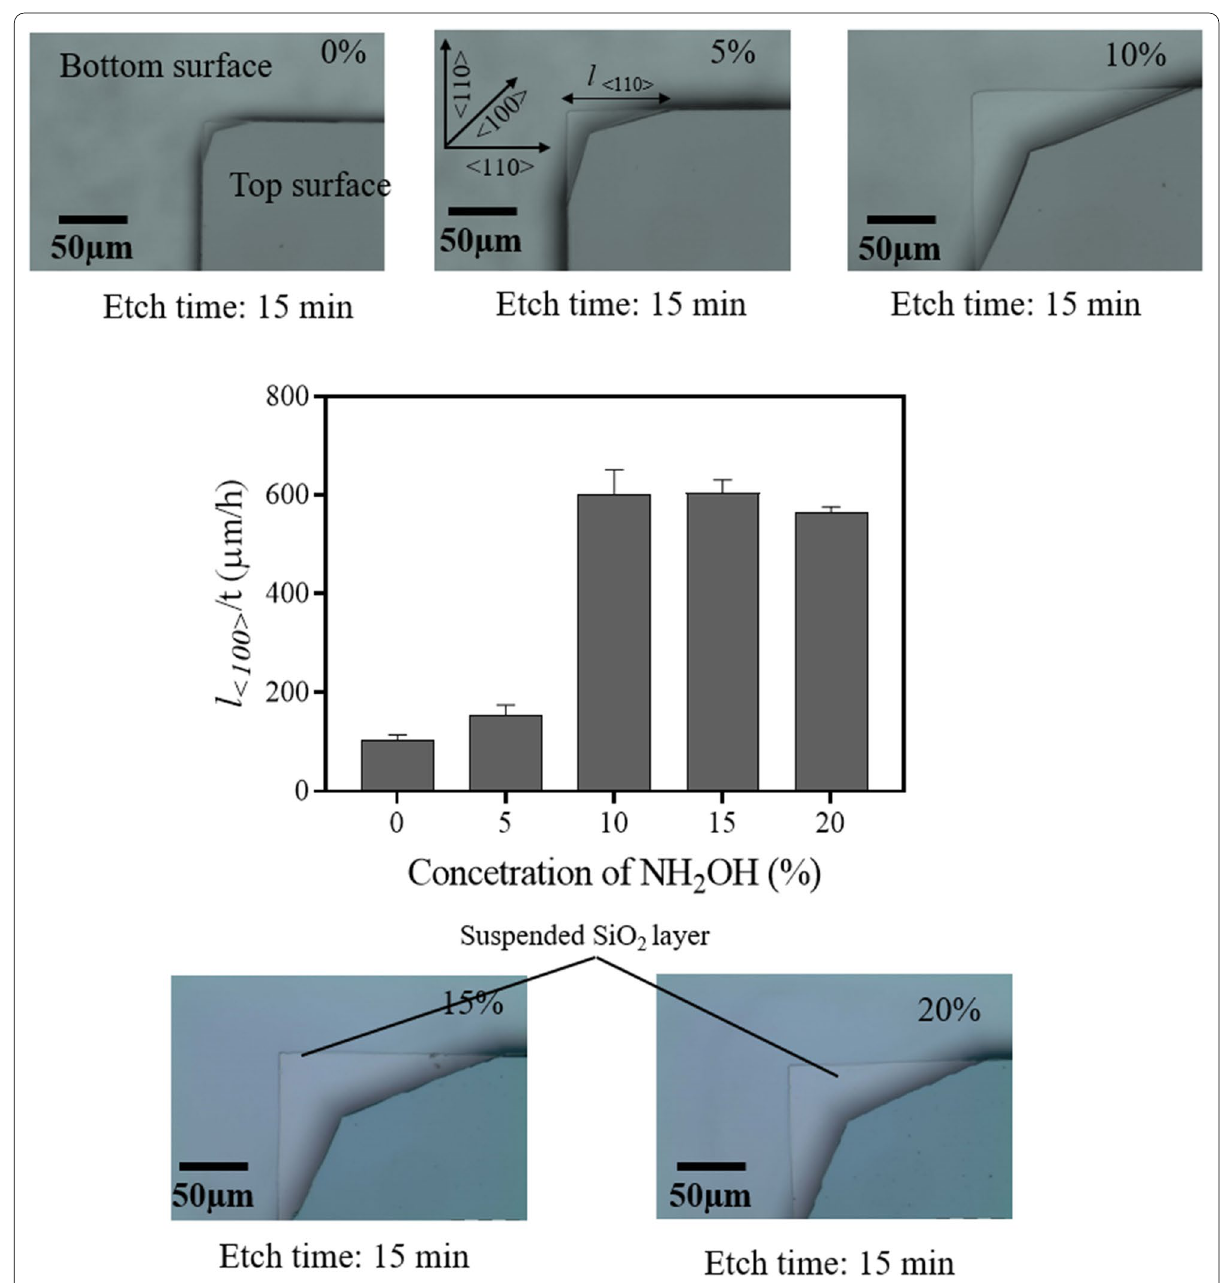
Fig. 53 Corner undercutting along < 110 > direction in pure and different concentrations of NH 2 OH-added 5 wt% TMAH at 70